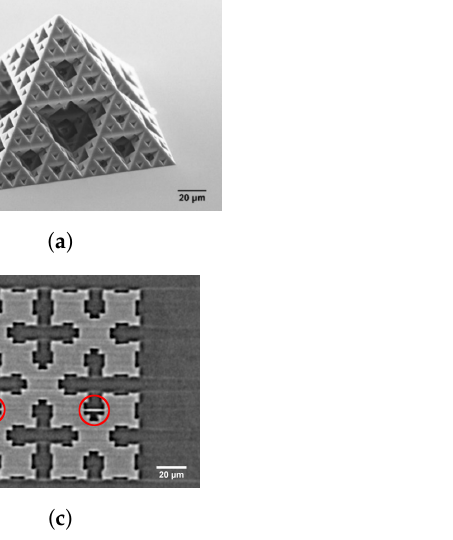
Figure 7. Views of a DLW fabricated fractal pyramid (sample 1): ( a ) SEM image, ( b ) 3D rendering from XCT and ( c ) XCT slice view parallel to the Z-plane (perpendicular to the building direction). Unintended polymerised lines are highlighted in ( c ). A 3D rendering of the binary STL-file is shown in ( d